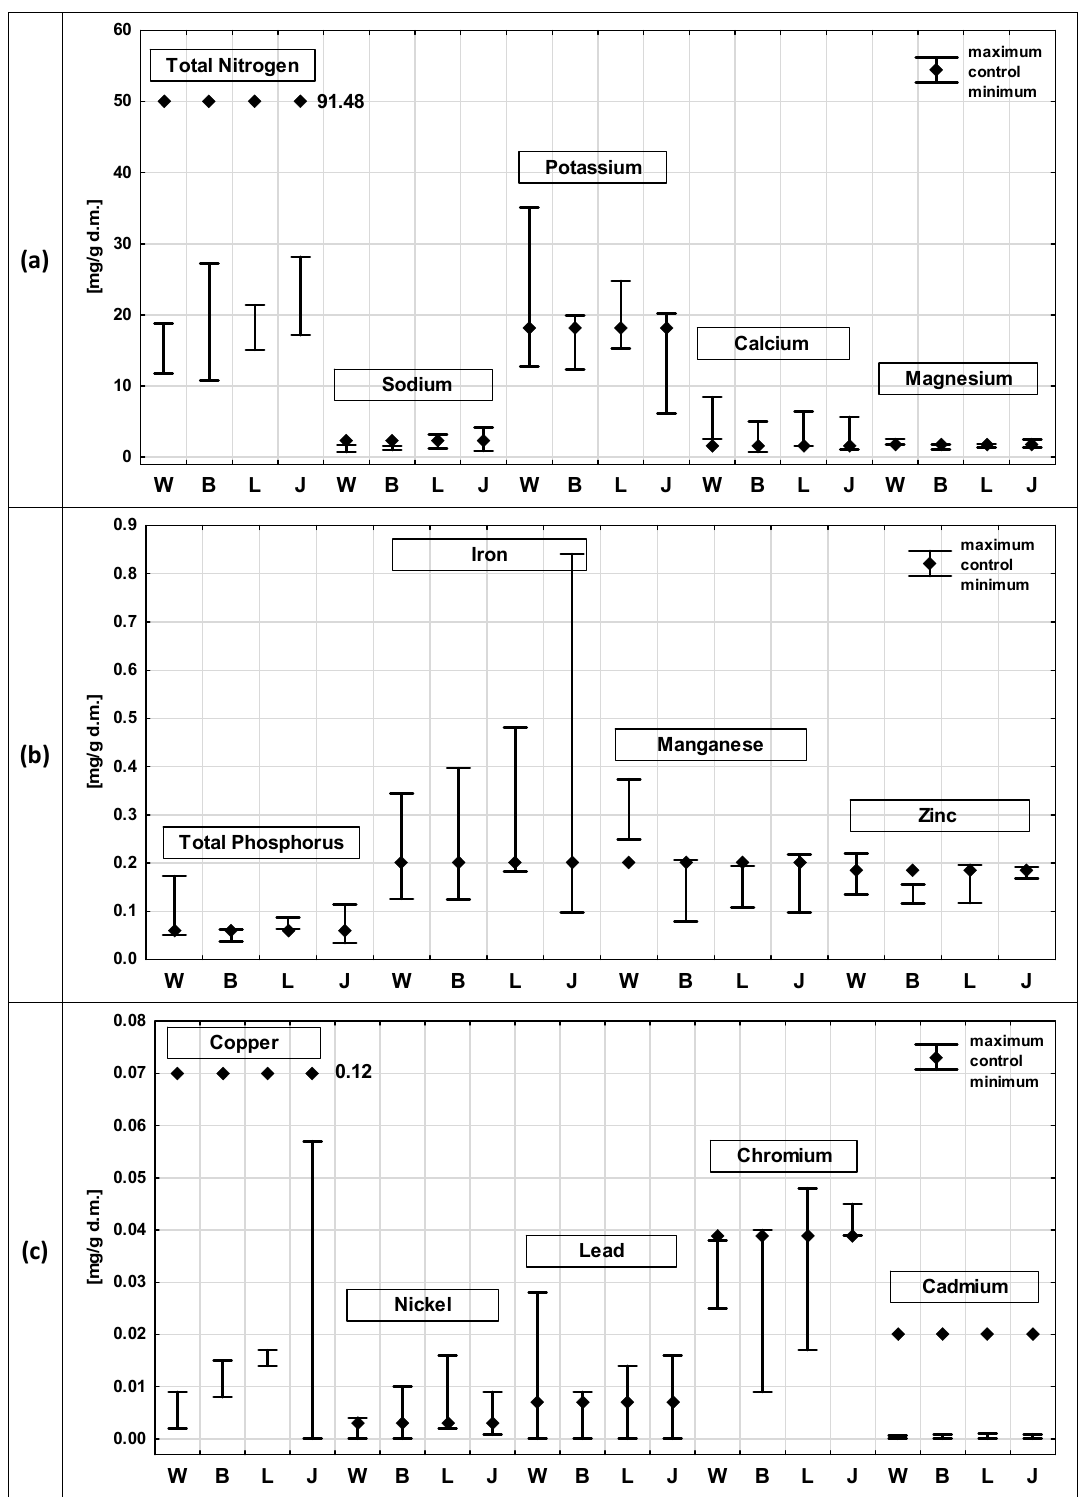
Figure 4. Comparison of chemical composition of plants after exposure to leachate from active (L — Legnica, J — Jawor) and closed (W — Wrocław, B — Bielawa) landfills with the composition of the control sample — results of analyses for Phragmites australis shoots: ( a ) contents of TN, sodium, potassium, calcium and magnesium; ( b ) contents of TP, iron, manganese and zinc; ( c ) contents of copper, nickel, lead, chromium and cadmium.